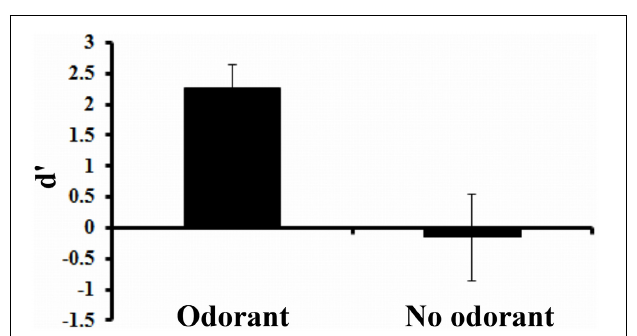
FIGURE 12 | Mean d (cid:2) ( ± SD ) in the two